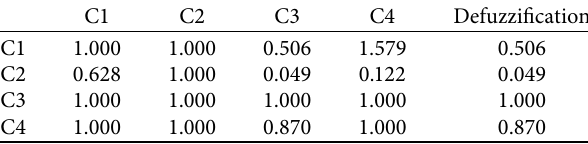
Table 13: Vector weight value ( w ) specification